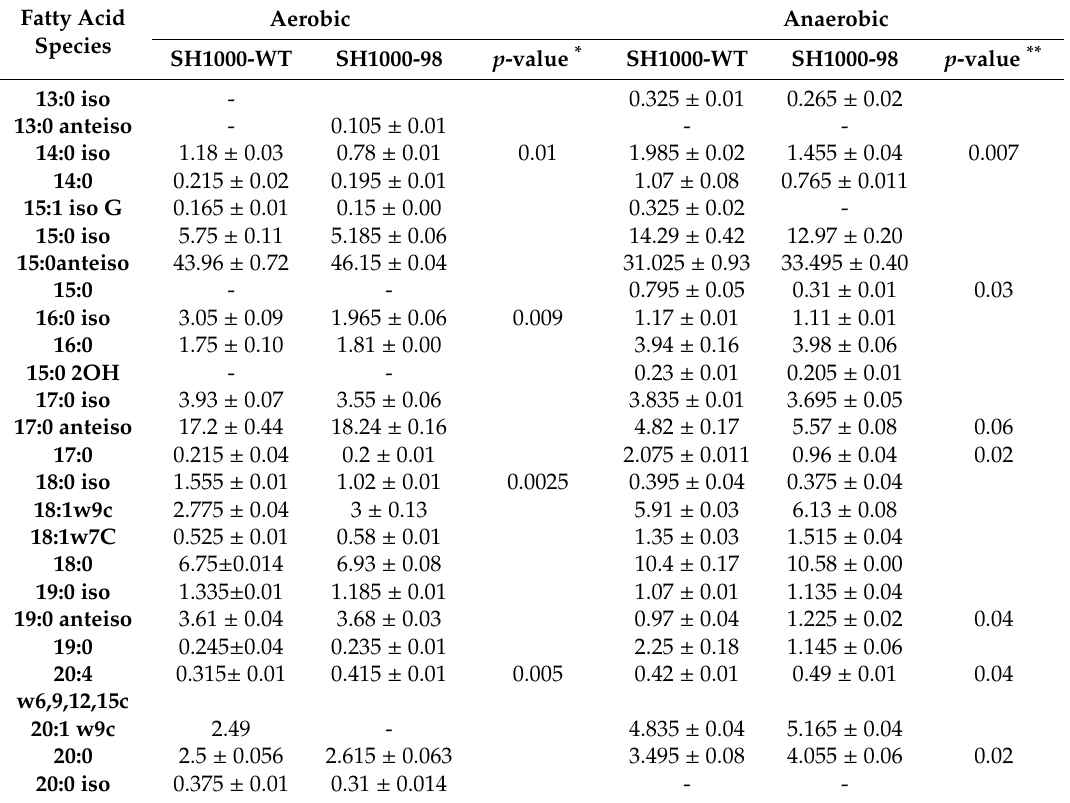
Table 3. Complete fatty acid analysis of strain-pair under aerobic and anaerobic